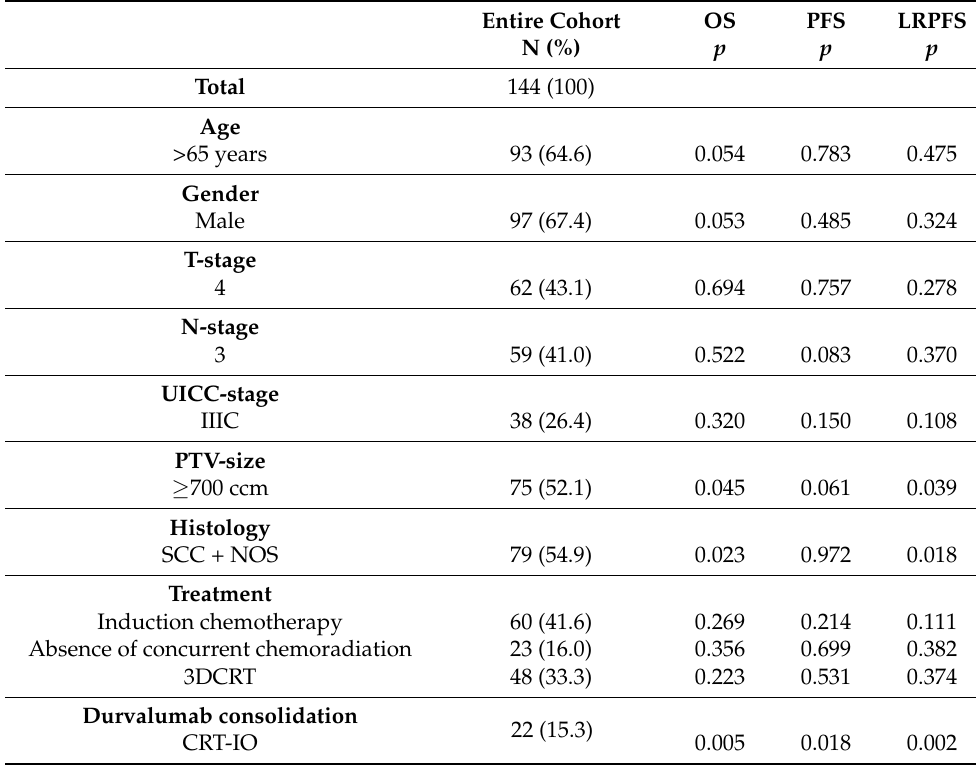
Table 2. Results of univariate analysis of the entire cohort